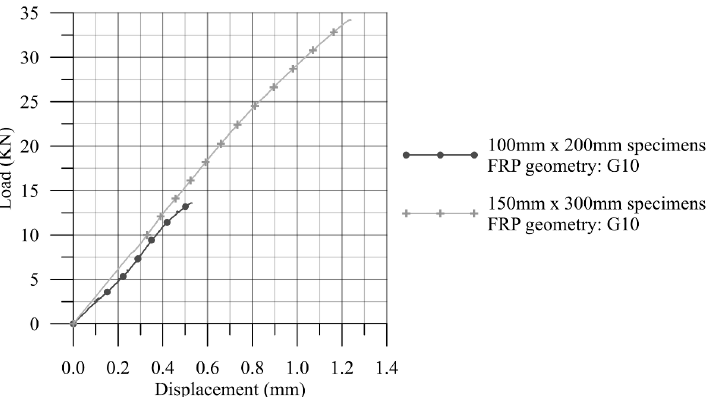
Figure 10. Plot of load versus displacement to the peak in experiments with the same FRP geometry and concrete